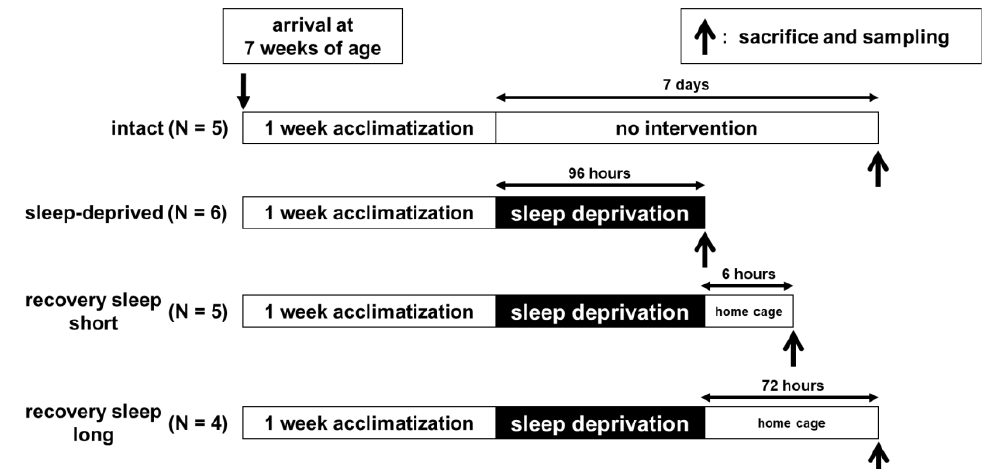
Figure 2. Experimental design. (1) Intact group (N = 5) animals were not subjected to any interven- tion. (2) Sleep-deprived (SD) group (N = 6) animals were subjected to sleep deprivation for 96